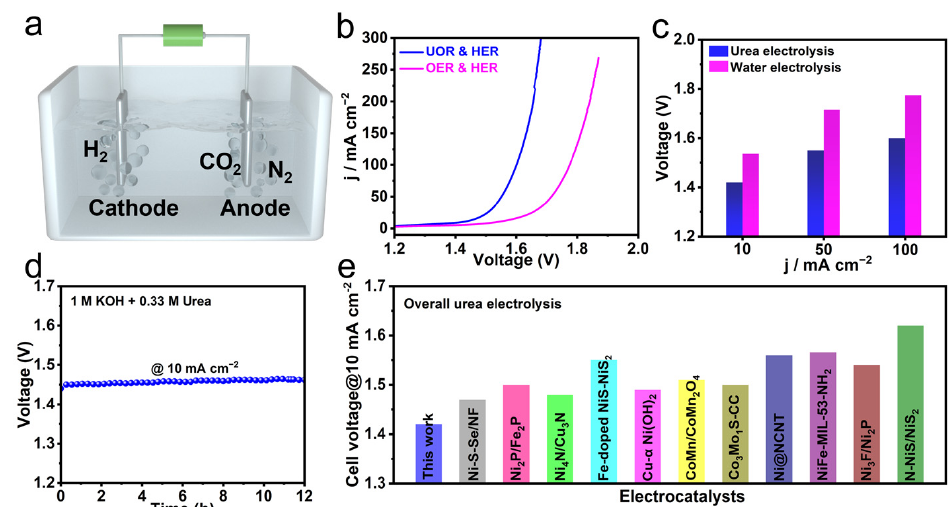
Figure 4. ( a ) Schematic illustration of a urea electrolytic electrolyzer using NiFe LDH-NiFeS x /NF as both the anode and cathode. ( b ) LSV curve of NiFe LDH-NiFeS x /NF for overall urea electrolysis and water splitting. ( c ) Comparison of potentials at different current densities for overall urea electrolysis and water splitting. ( d ) Long-term stability test of urea electrolysis. ( e ) Comparison of cell voltages of the bifunctional urea electrocatalysts.